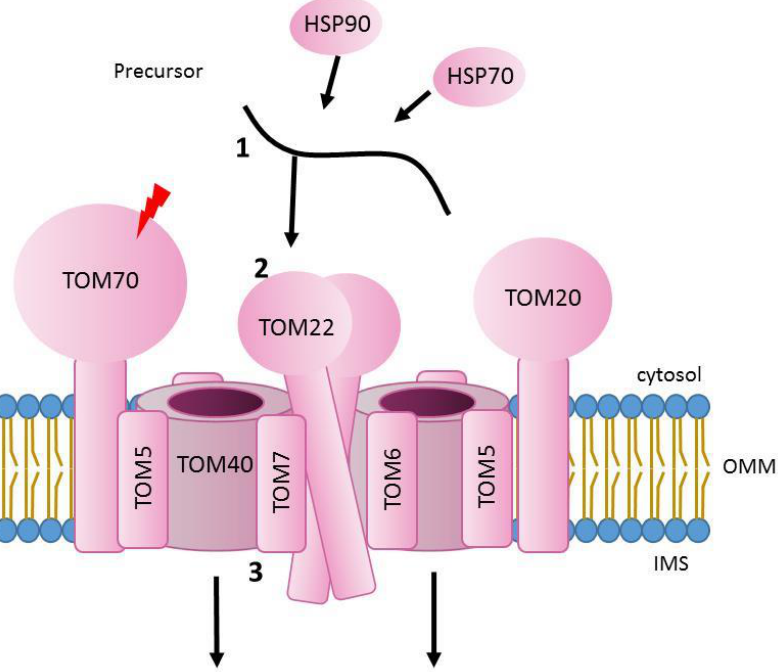
Figure 1. Scheme of translocation of mitochondrial precursors through the outer mitochondrial membrane. 1. Precursors are stabilized in the cytosol with the assistance of specific chaperones like HSP70 and HSP90. 2. Precursors are then recognized by specific receptor subunits (TOM70, TOM22 and TOM20) of TOM complex and directed to the channel forming subunit TOM40. 3. Proteins